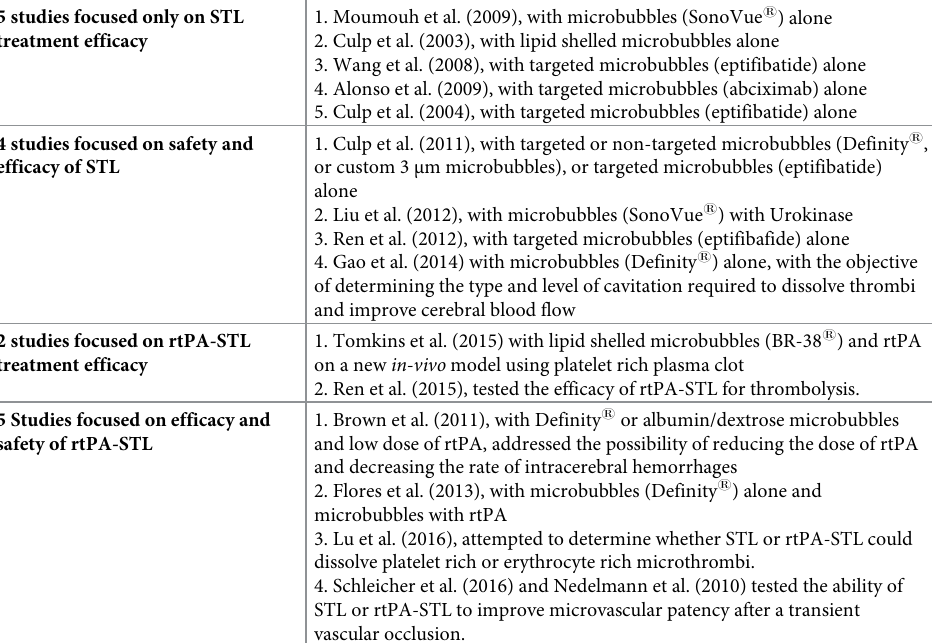
Table 2. General description of studies that fulfilled the inclusion/exclusion criteria. 5 studies focused only on STL treatment